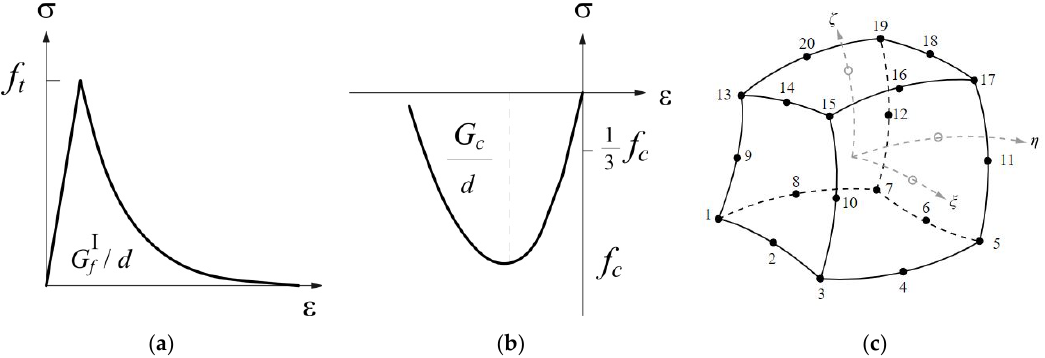
Figure 2. ( a ) Exponential tensile law, ( b ) parabolic compressive law, ( c ) CHX60, a type of solid element mesh. A three-dimensional element, CX60, is adopted for the discretization of the continuum; it is a 20-node iso-parametric solid brick element based on a quadratic interpolation